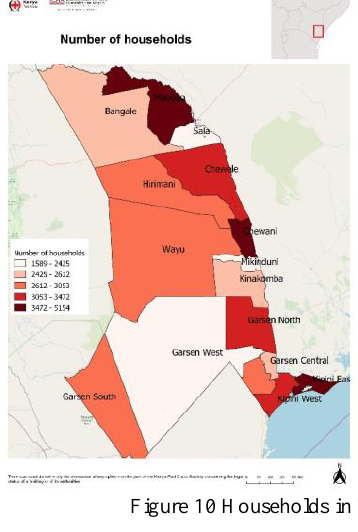
Figure 10 Households in Tana river